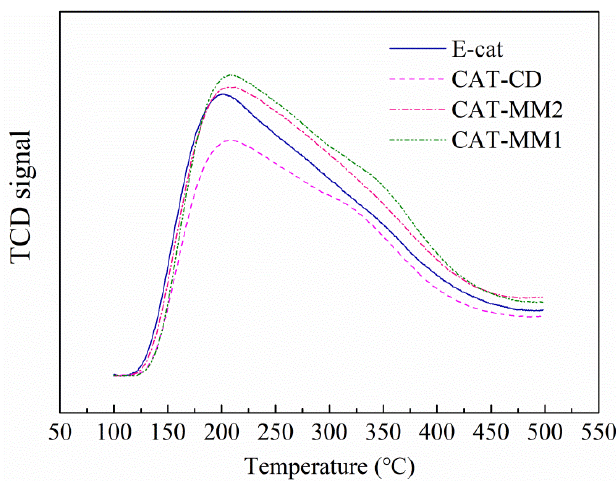
Figure 9. NH 3 -TCD (Thermal Conductivity Detector) profiles of the different catalysts.